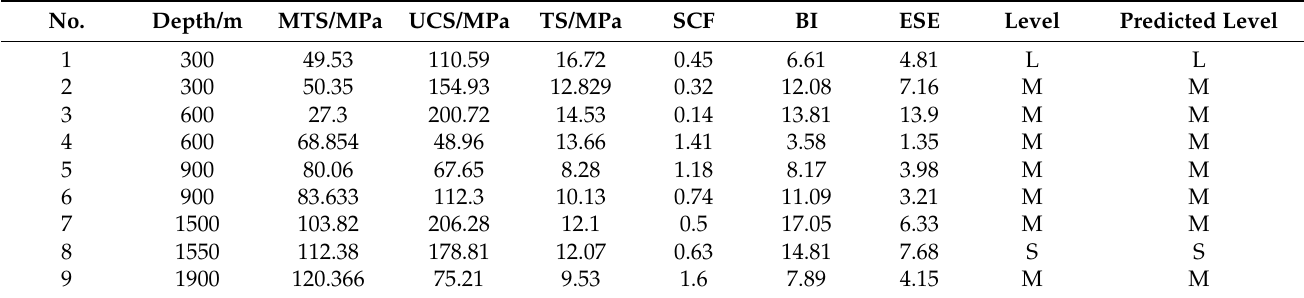
Table 3. The measured datasets in Sanshandao Gold Mine.